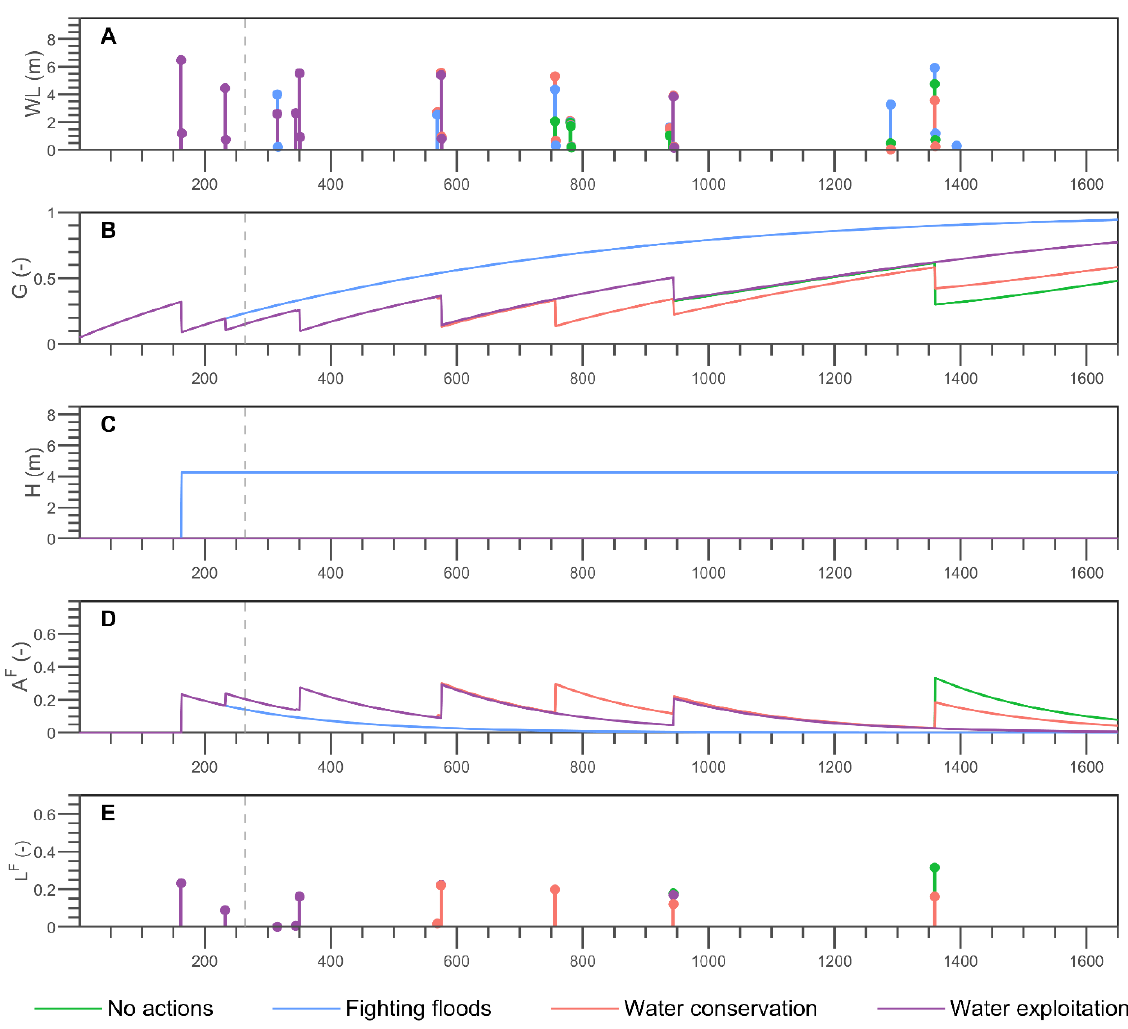
Figure A20. Flooding-based variables of the synthetic experiments additional scenario #6 considering dam construction and human-flood interactions with the four water management strategies introduced in this study. (A) Water level (WL), (B) proportion of population in floodplain (G), (C) levee height (H), (D) flood awareness (AF), and (E) flood losses (LF). The grey dashed line indicates the construction of the Wivenhoe